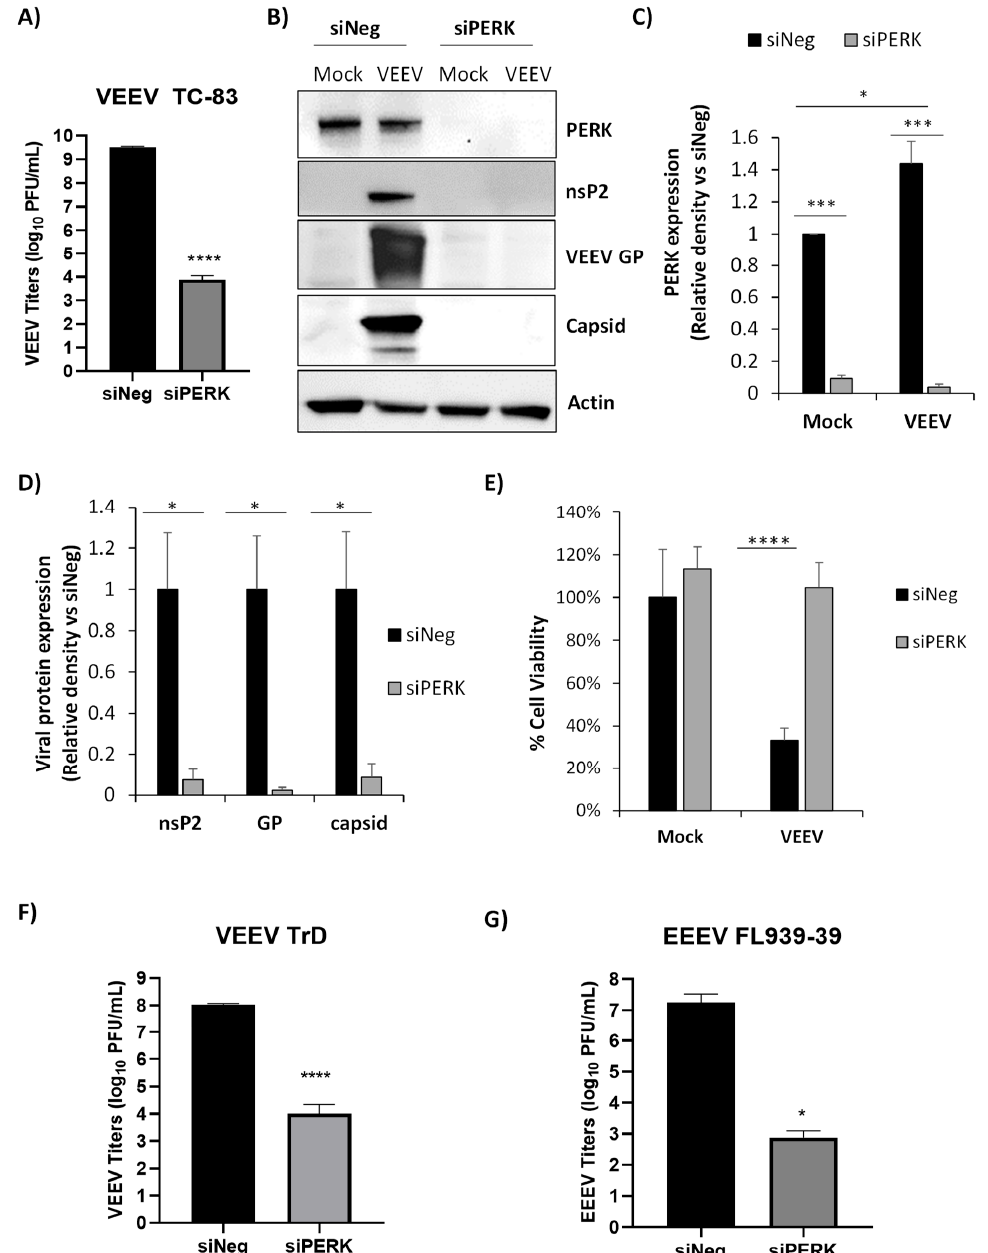
Figure 1. siRNA knockdown of protein kinase R (PKR)-like endoplasmic reticulum kinase (PERK) dramatically decreases Venezuelan equine encephalitis (VEEV) and eastern equine encephalitis virus (EEEV) replication in primary astrocytes. Primary human astrocytes were transfected with 100 nM of siNeg or siPERK siRNAs. At 48 h post transfection, cells were mock infected or infected with VEEV TC-83 (MOI 5). ( A ) Viral replication was analyzed via plaque assays in Vero cells using supernatants collected at 18 hpi. ( B ) Cell lysates were collected at 18 hpi and analyzed by immunoblot. PVDF membranes were probed for levels of PERK, VEEV nsP2, VEEV GP, and VEEV capsid. β -Actin was used as a loading control. ( C , D ) Data show the quantitation of the respective immunoblots. Protein levels expressed in each blot were normalized to β -actin and normalized values were calculated relative to siNeg-transfected cells. N = 3, * p ≤ 0.05, *** p ≤ 0.001. ( E ) Cell viability was measured using CellTiter-Glo assay at 48 hpi. Data were normalized to siNeg-transfected and mock-infected cells. Data are expressed as the mean ± SD ( n = 4). **** p ≤ 0.0001. ( F , G ) Primary astrocytes were transfected with 100 nM of siNeg or siPERK siRNAs. At 48 h post transfection, cells were infected with ( F ) VEEV TrD (MOI 5) or ( G ) EEEV FL93-939 (MOI 5). Viral replication was analyzed using supernatants collected at 18 hpi via plaque assays in Vero cells. Data are expressed as the mean ± SD ( n = 3 for siNeg and n = 5 for siPERK samples). * p ≤ 0.05, **** p ≤